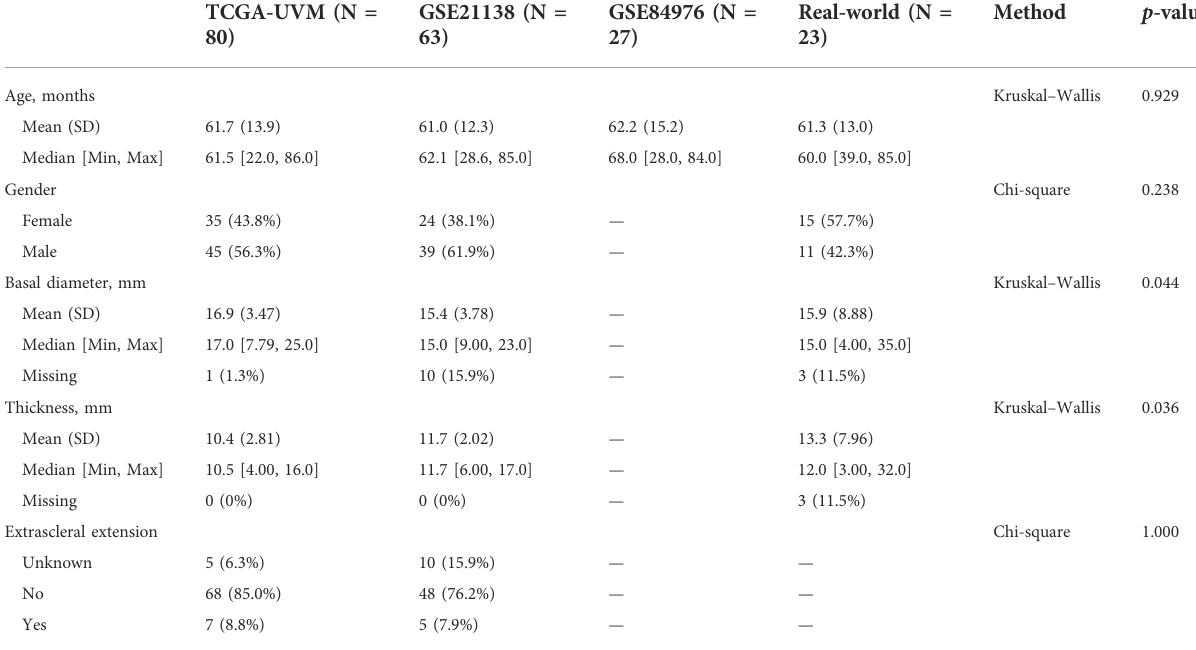
TABLE 1 Basic informal of enrolled